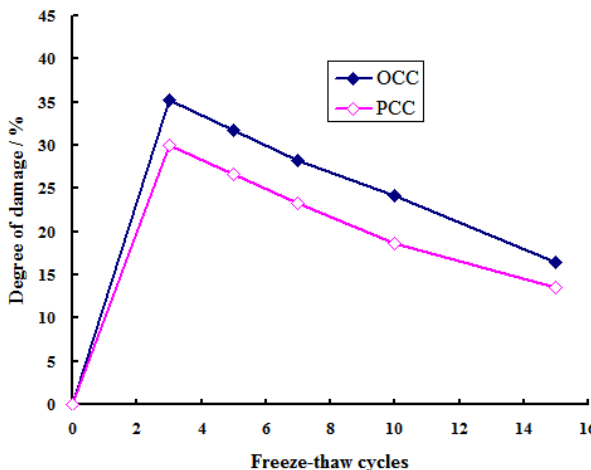
Figure 6. The influence of number of freeze–thaw cycles on the degree of damage.